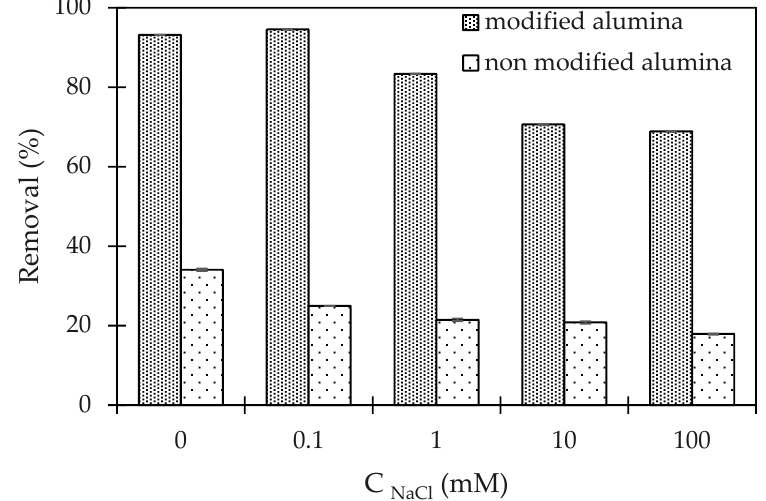
Figure 3. Effect of pH on ciprofloxacin (CFX) removal using α -Al 2 O 3 (non-modified alumina) and PMA (modified Al 2 O 3 ) from pH 2 to 10. (Ci (CFX) = 10 mg/L, contact time 90 min, adsorbent dosage 5 mg/mL, 1-mM NaCl). Error bars show standard deviation of three replicates.